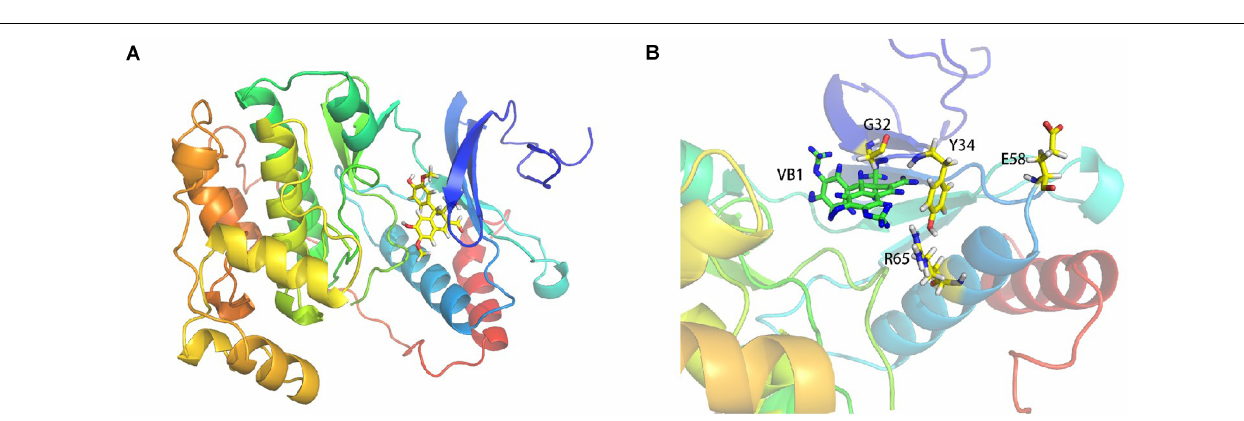
FIGURE 3 | The possible target sites of MAPK1 binding VB1 are predicted by computer-aided methods including molecular docking and molecular dynamics simulation. The MAPK1-VB1 binding site was predicted by Discovery Studio 2.5 and Autodock Vina. The molecular docking study and the Molecular dynamics (MD) simulations were performed to explore the binding details base the docking results. (A) The molecular docking and molecular dynamics simulation results showed VB1 could directly bind MAPK1 protein. (B) The five amino acid residues (G32, Y34, K46, E58, and R65) of MAPK1 were predicted and K338 residue was another possible key residue through computer-aid calculation (data not